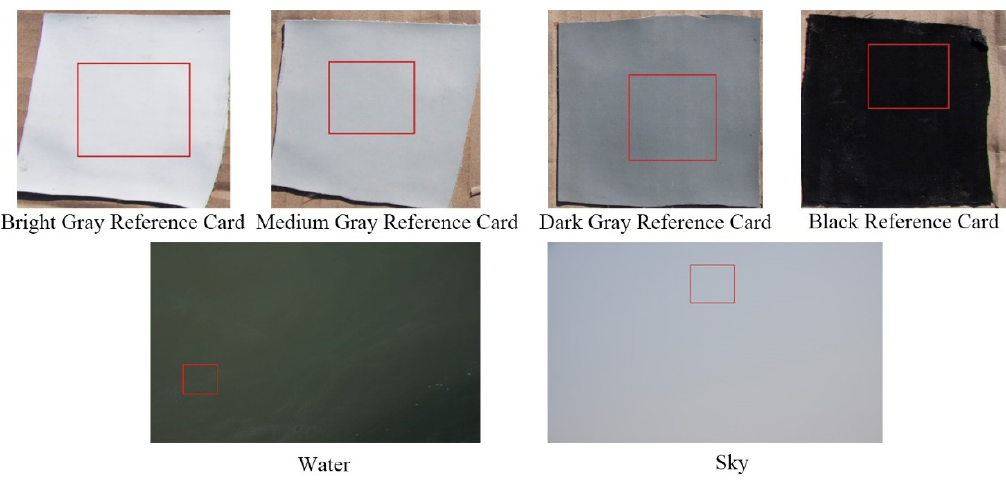
Figure 4. Sample images of four reference cards, water, and sky taken by a digital camera. The red box indicates the position of the uniform area after clipping.